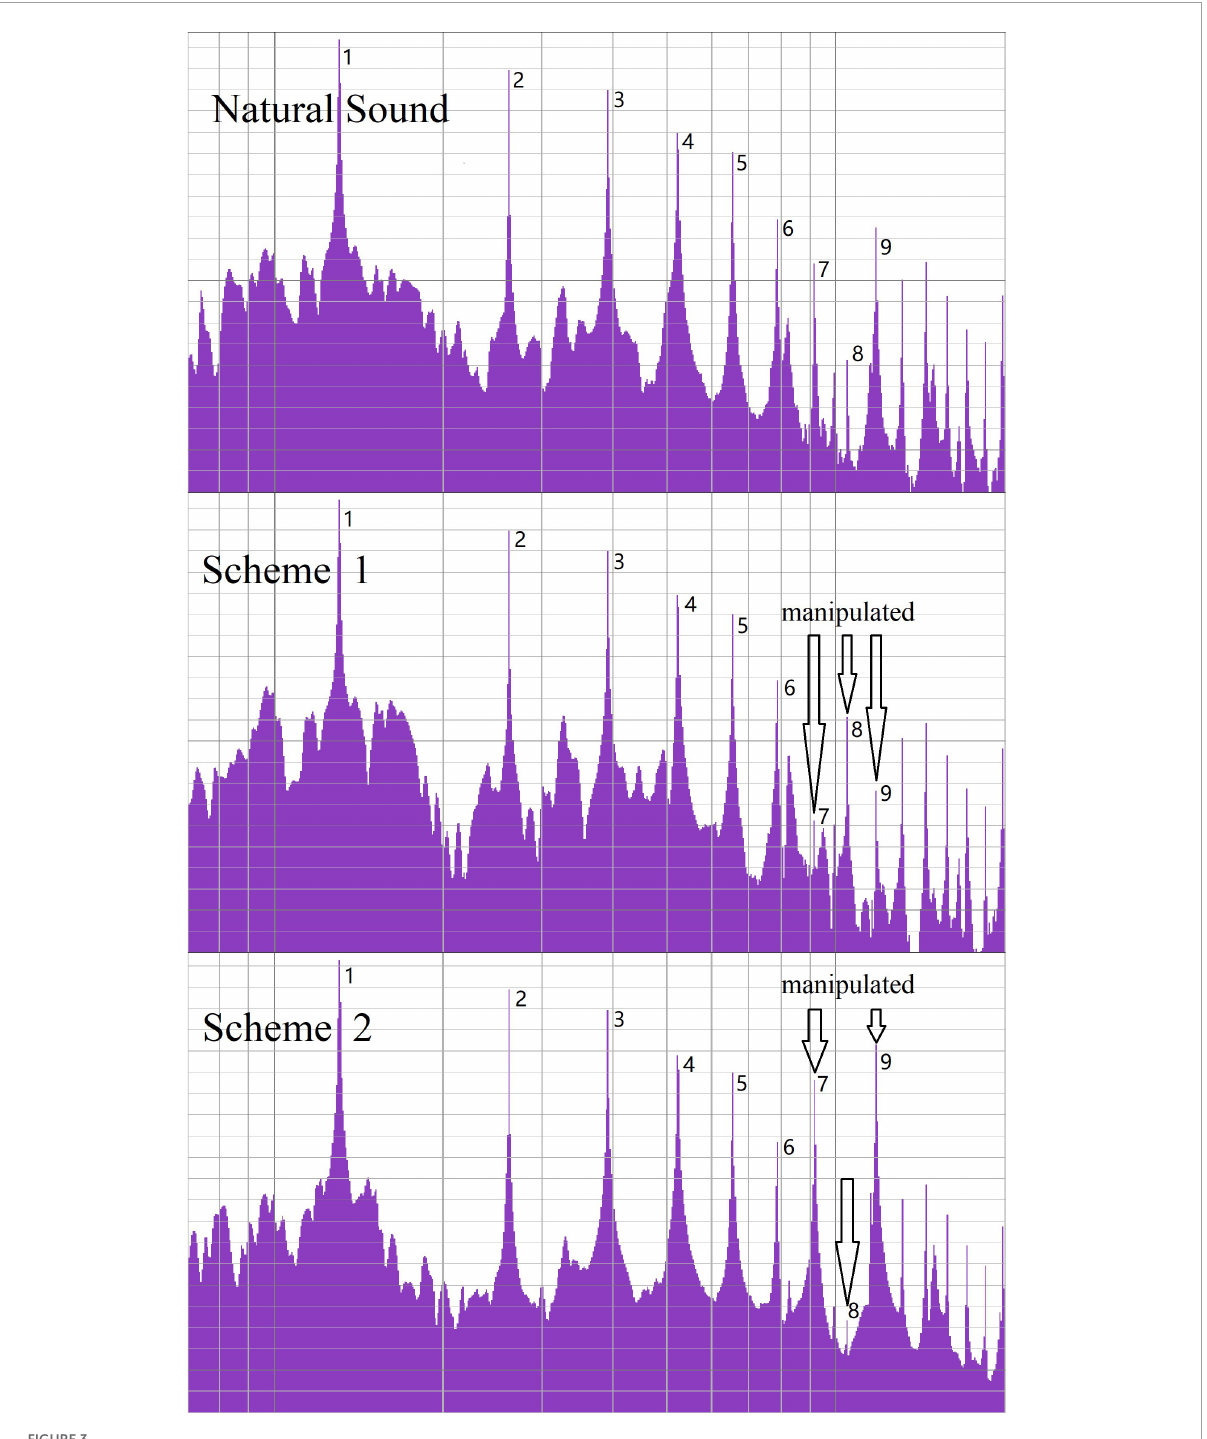
FIGURE3 Harmonic loudness in investigation